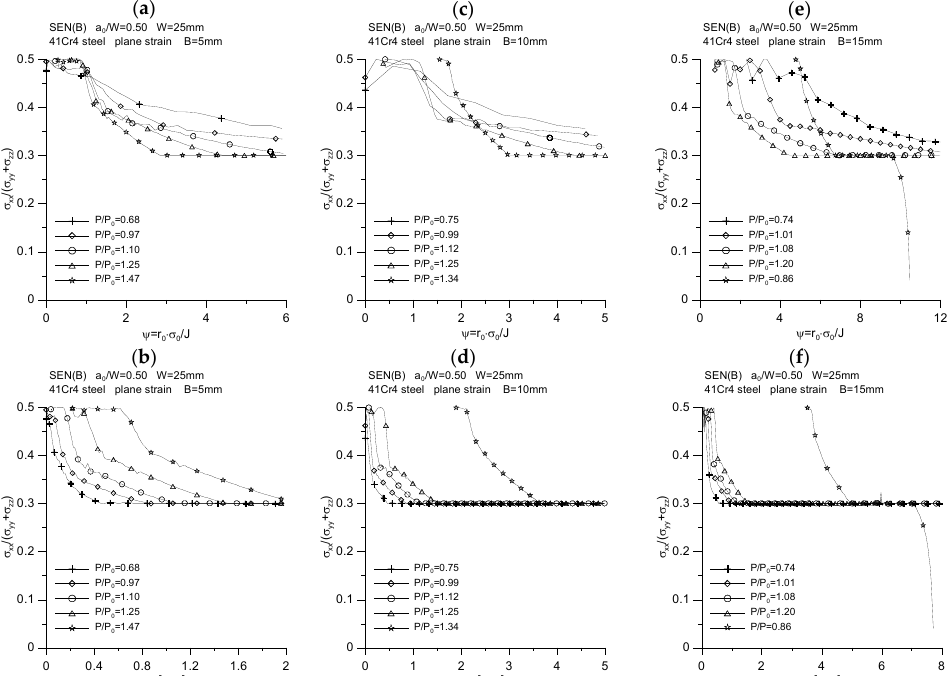
Figure 9. Distribution of the stress triaxiality coefficient, σ xx /( σ zz + σ yy ), for three specimens used in the crack propagation simulation. The graphs ( a , c , e ) were made for the normalized distance from the crack tip, ψ = r 0 ∙ σ 0 / J , while the graphs ( b , d , f ) were prepared for the physical distance from the initial crack tip position, r 0 . The figures show the distributions for the characteristic moments provided in Table 2.